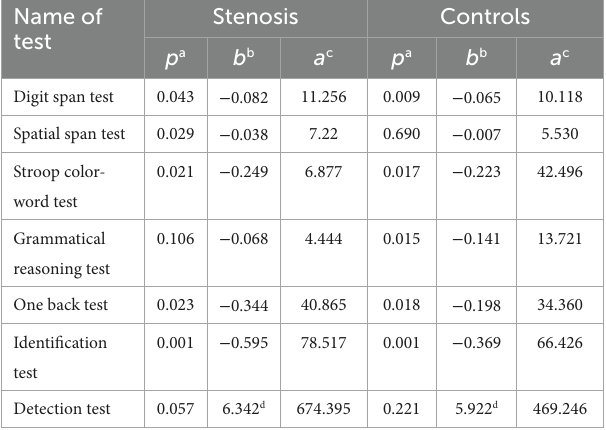
TABLE 4 Area under the ROC curve of 7 cognitive tests and the comprehensive